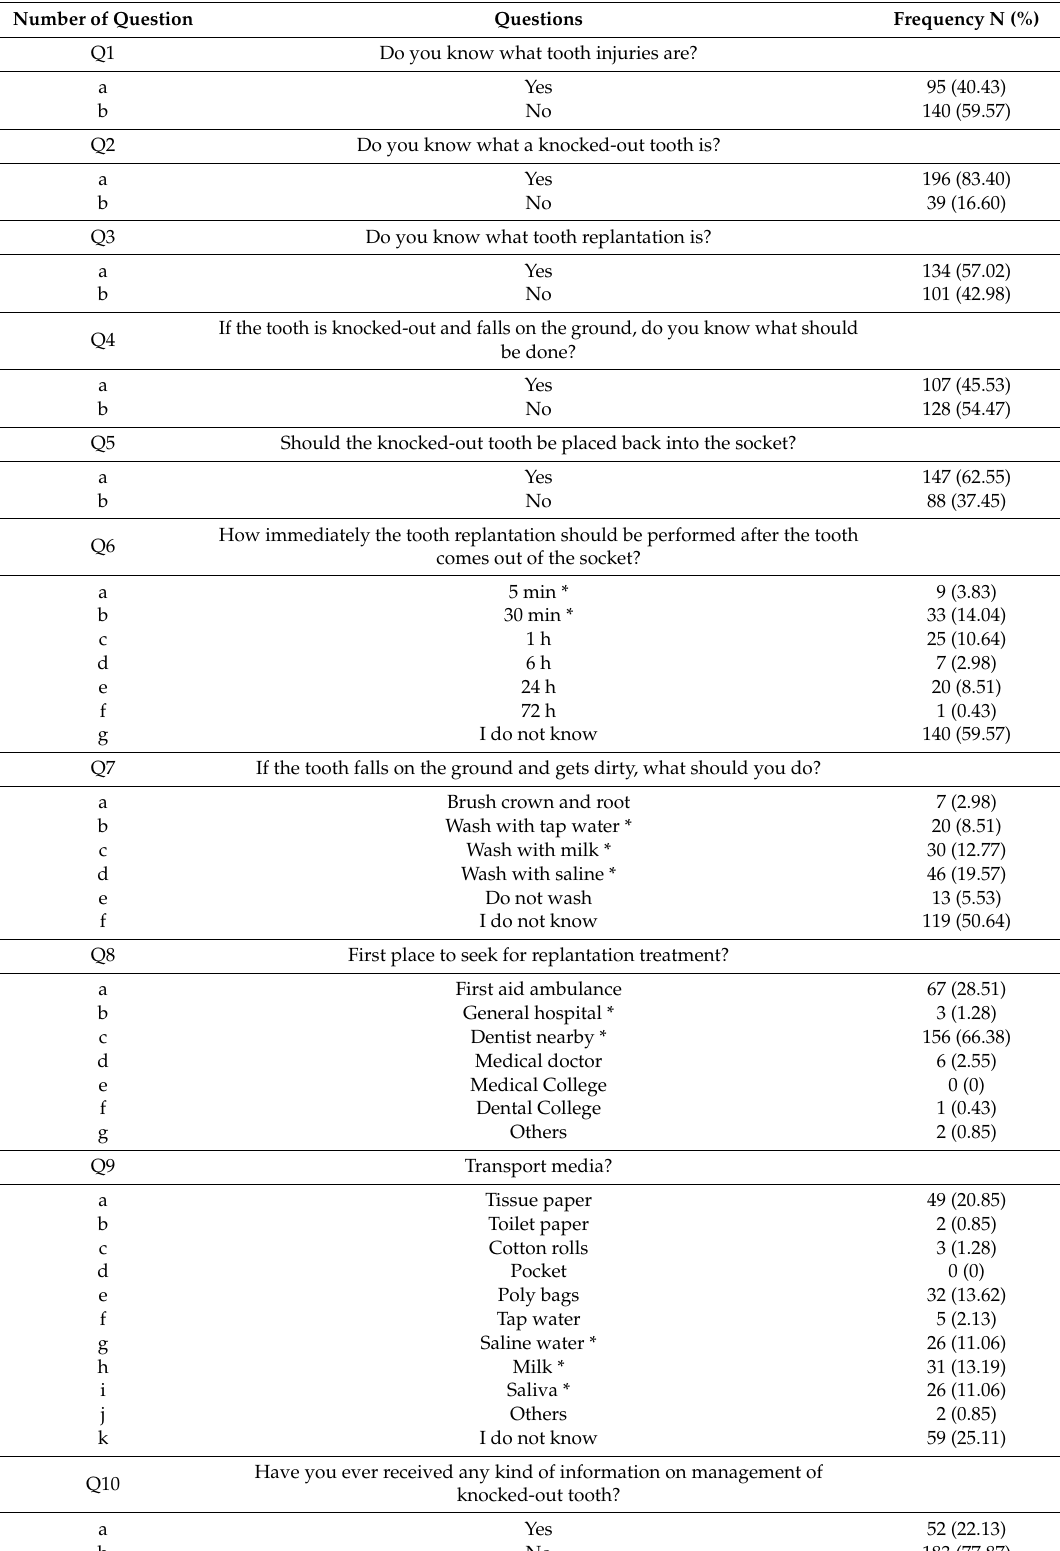
Table 1. Students’ responses to the applied